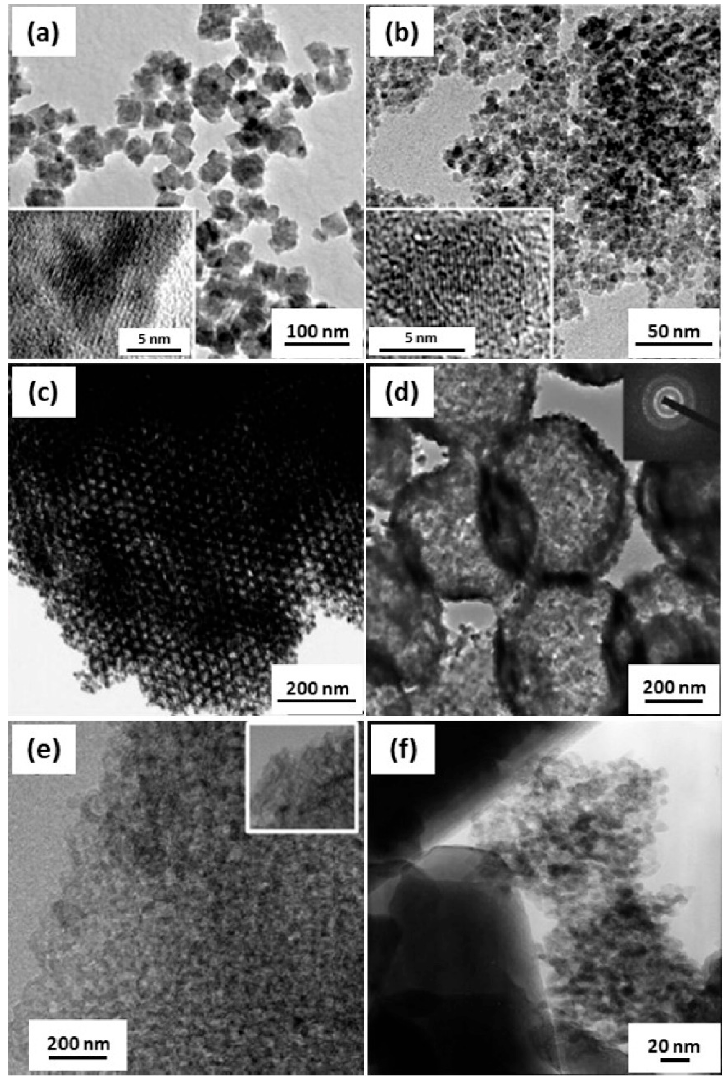
Figure 1. (a–f) A set of TEM images of diverse MO nanostructures : ( a ) MnO and ( b ) Fe 3 O